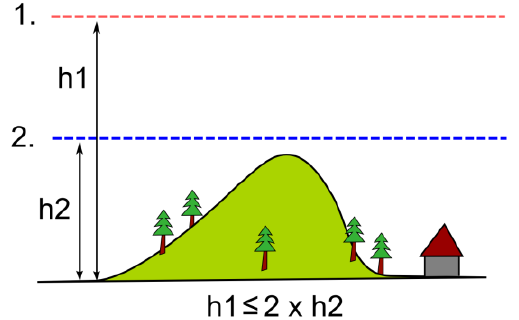
Figure 4: Multi-level flight